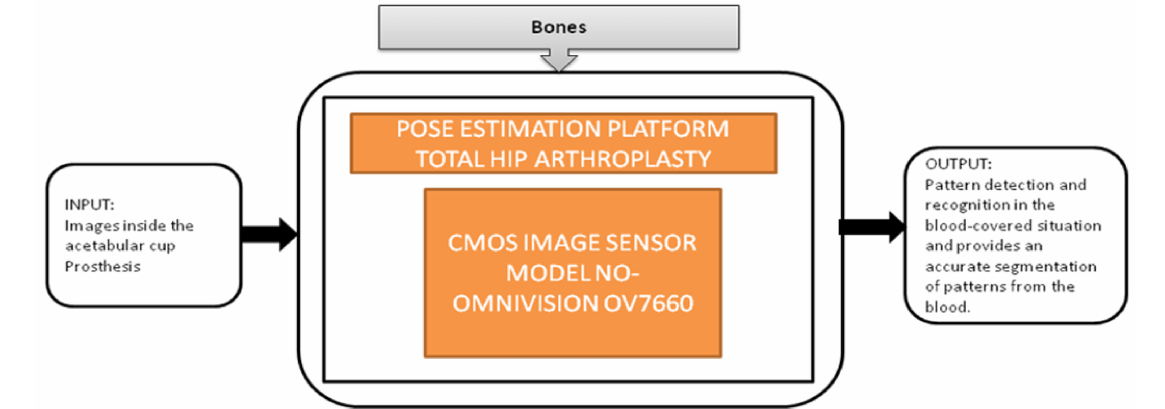
Figure 37. Pose estimation platform for total hip